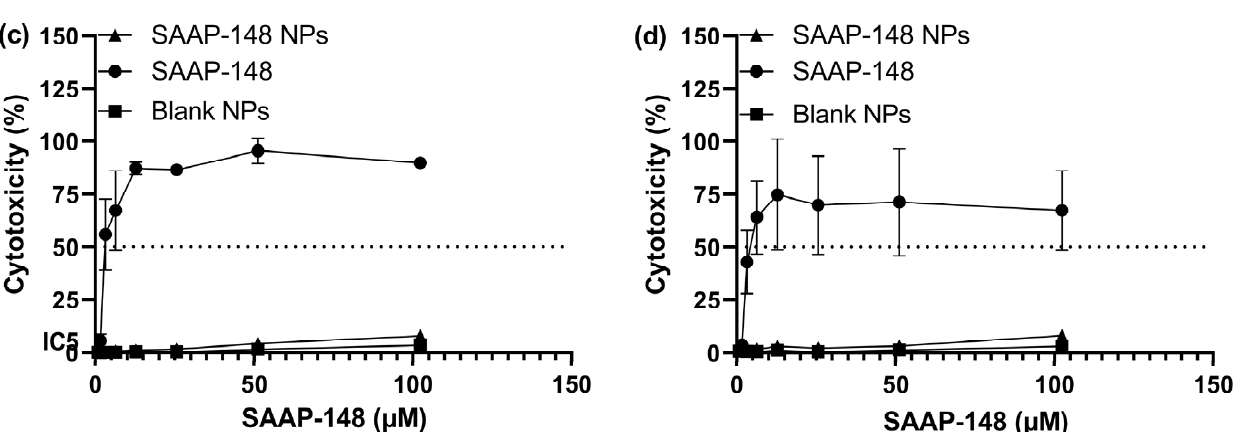
Figure 2. Cytotoxicity upon exposure of human skin fibroblasts monoculture to SAAP-148 NPs (triangles), SAAP-148 solution (circles), and blank NPs (squares). Metabolic activity based on water- soluble tetrazolium salt (WST-1) assay after ( a ) 4 h and ( b ) 24 h. Cytotoxicity against human skin fibroblasts, after ( c ) 4 h and ( d ) 24 h, based on lactate dehydrogenase (LDH) release. Metabolic activity and cytotoxicity assays were both performed in 0.5% human serum medium at 37 ◦ C, with 95% humidity and 5% CO 2 . Data are retrieved from the mean of three biological replicates performed with three technical duplicates ( n = 3). Inhibitory concentration (IC 50 ) indicates the inhibitory concentration to induce 50% cytotoxicity.